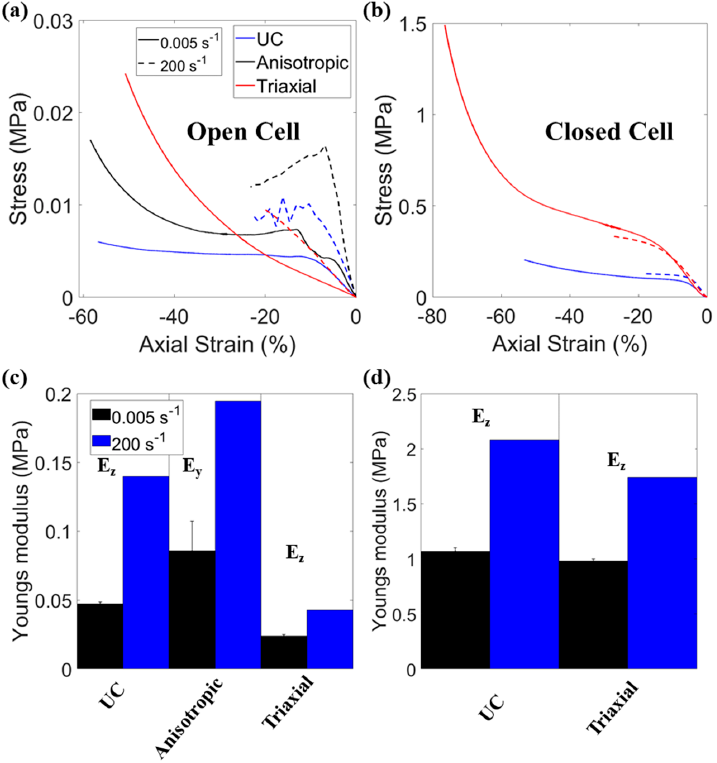
Figure 6. ( a,b ) Stress vs. axial engineering strain at minimum and maximum strain rates, for samples with median stress at 10% compression of ( a ) open cell and ( b ) closed cell foam. ( c,d ) Mean Young’s moduli of ( c ) open cell foams and ( d ) closed cell foams at minimum and maximum applied strain rates, measured to 2% compression, error bars show 1 standard deviation. Tested axis labelled for each foam.